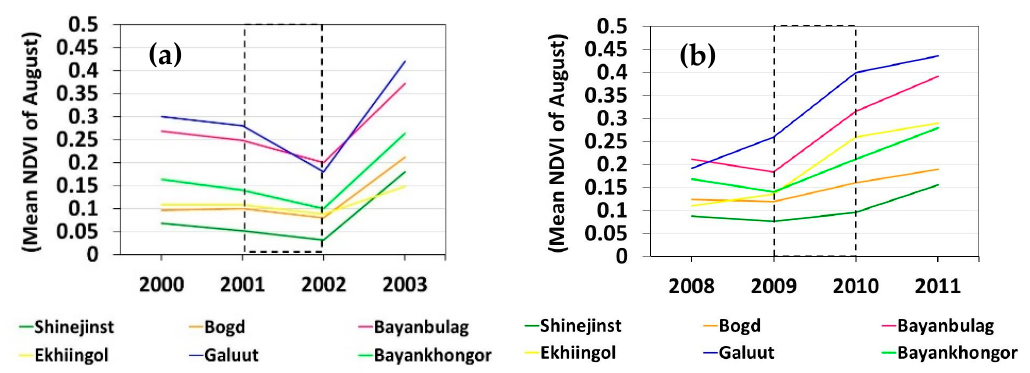
Figure 5. Mean NDVI of August vegetation trends caused by the ( a ) 2001 / 2002 and ( b ) 2009 / 2010 dzud events at different stations in the study area.